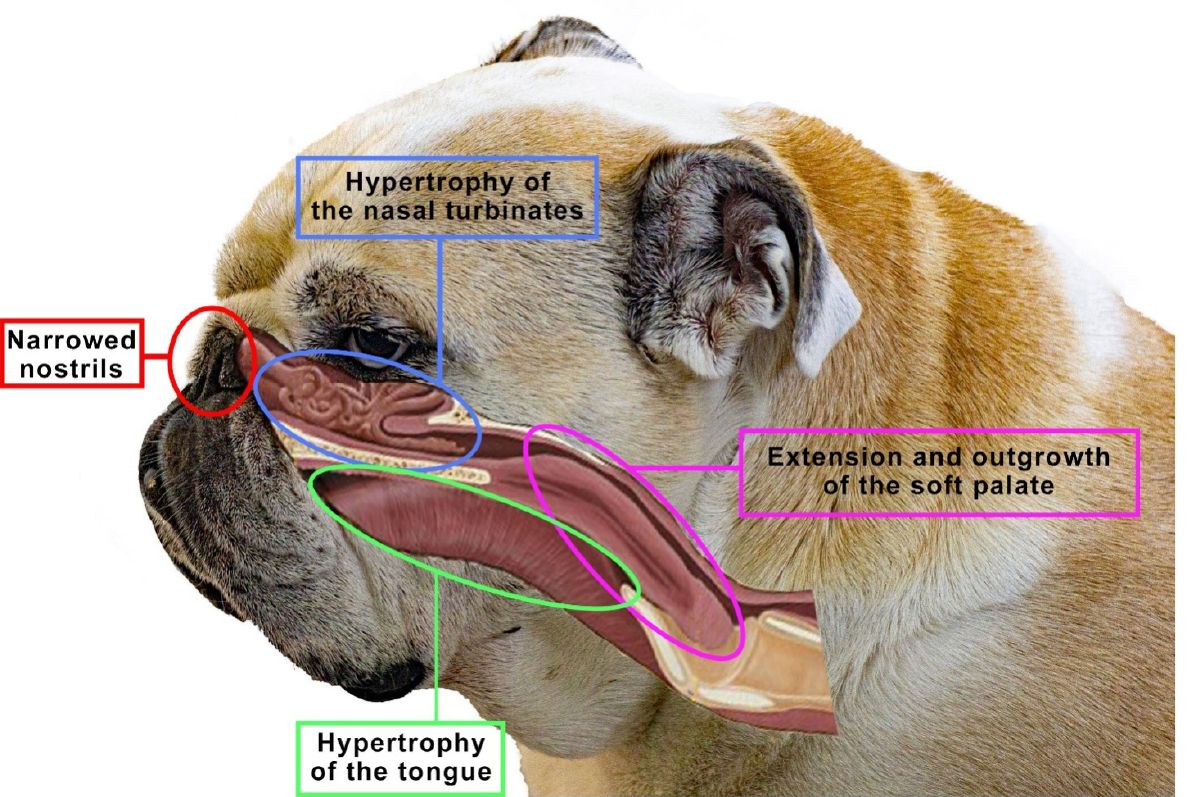
Figure 5. The figure shows an English bulldog. Visible here are signs that are typical for many brachycephalics, classified as the brachycephalic syndrome, such as narrowed nostrils, hypertrophy of the tongue, soft palate or nasal turbinates. Based on